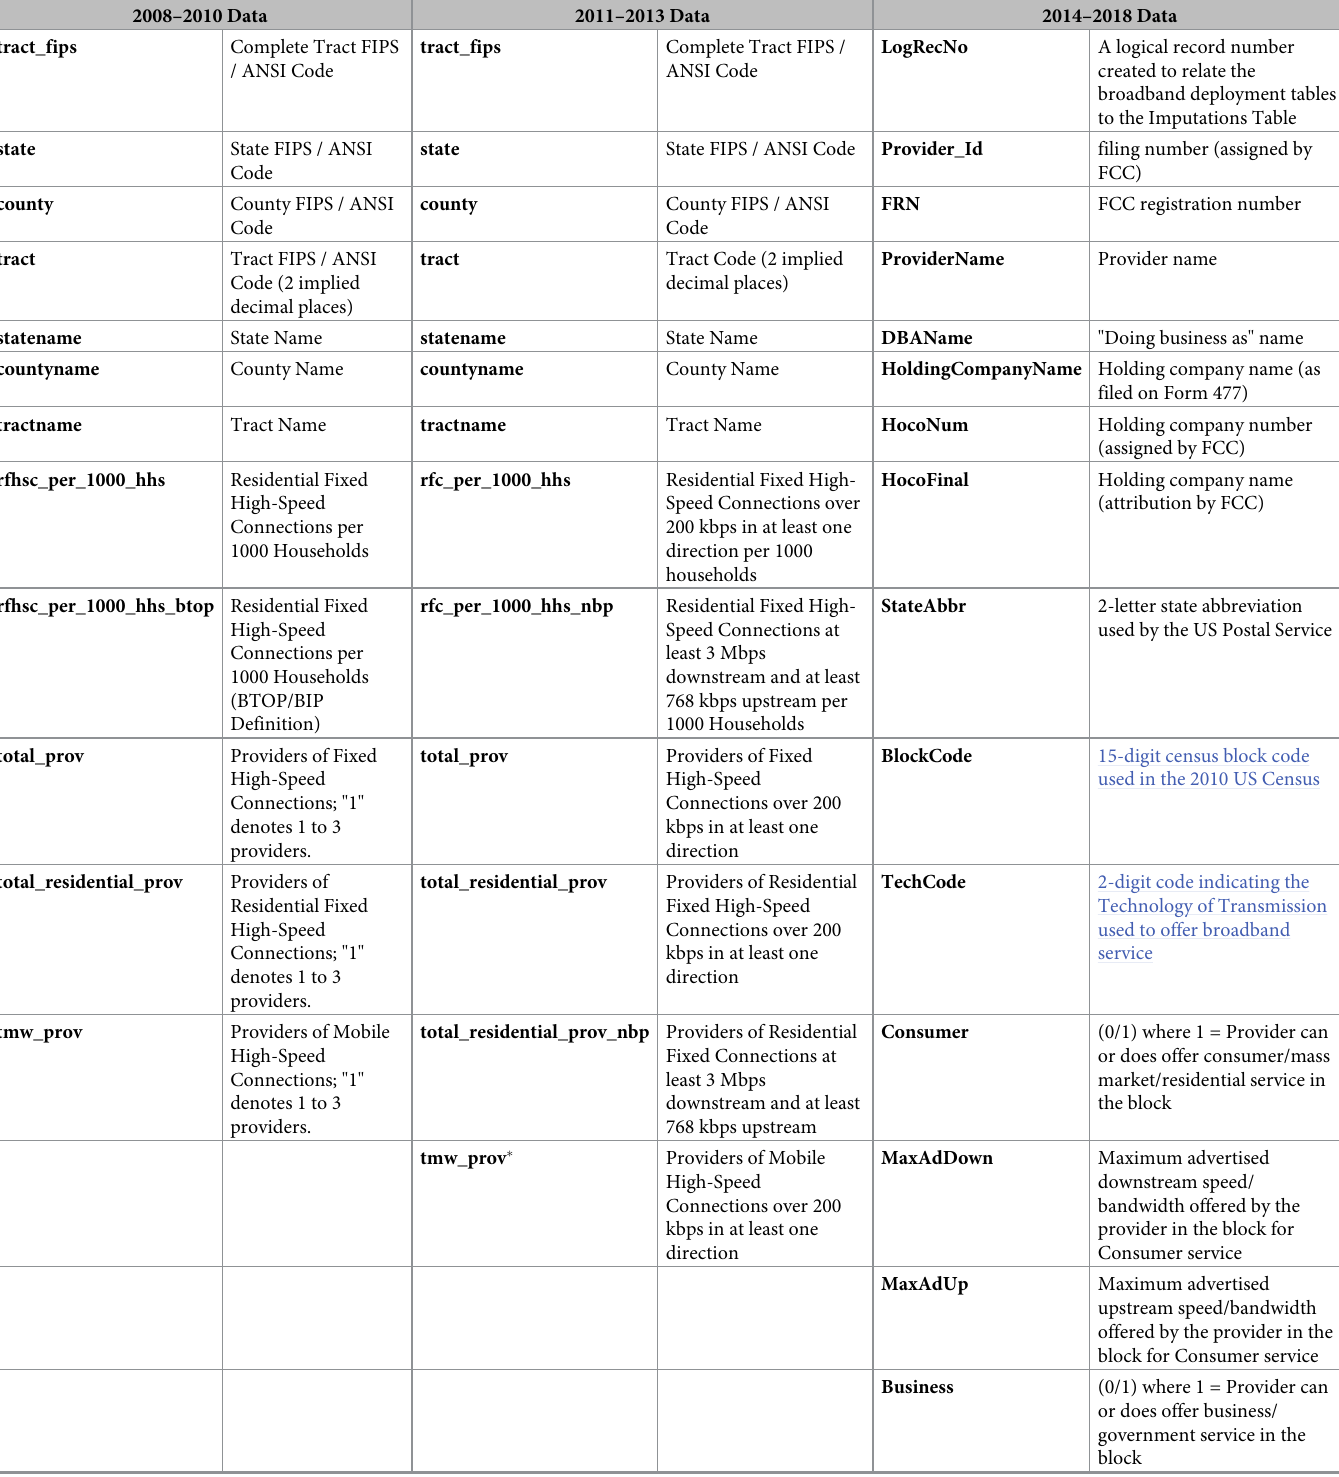
Table 2. Data fields for each iteration of the form 477